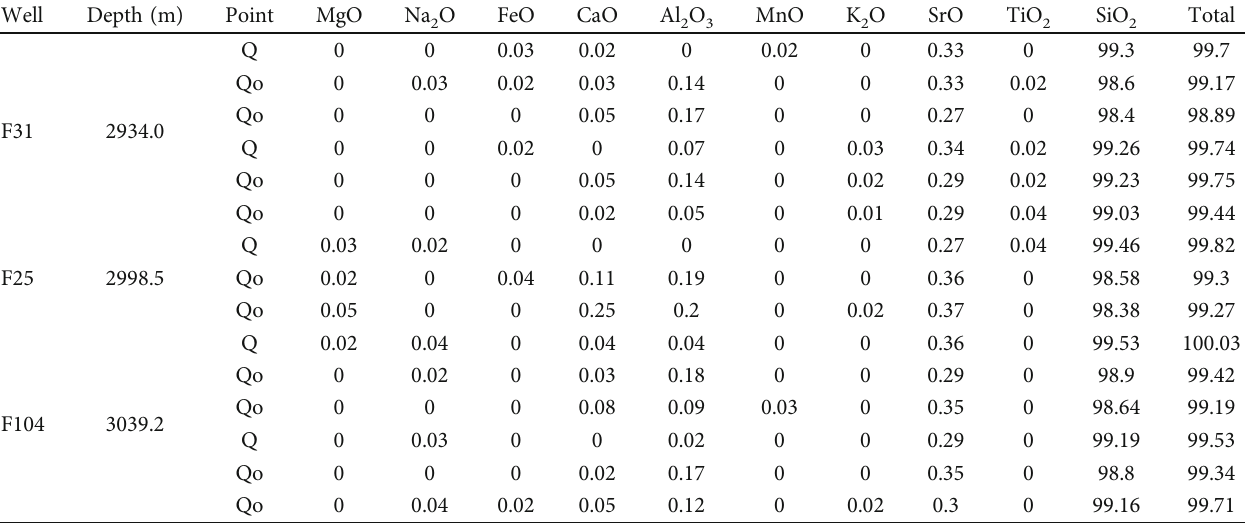
Table 4: Electronic probe microanalysis for quartz in the Es3 sandstone (wt%). Well Depth (m)